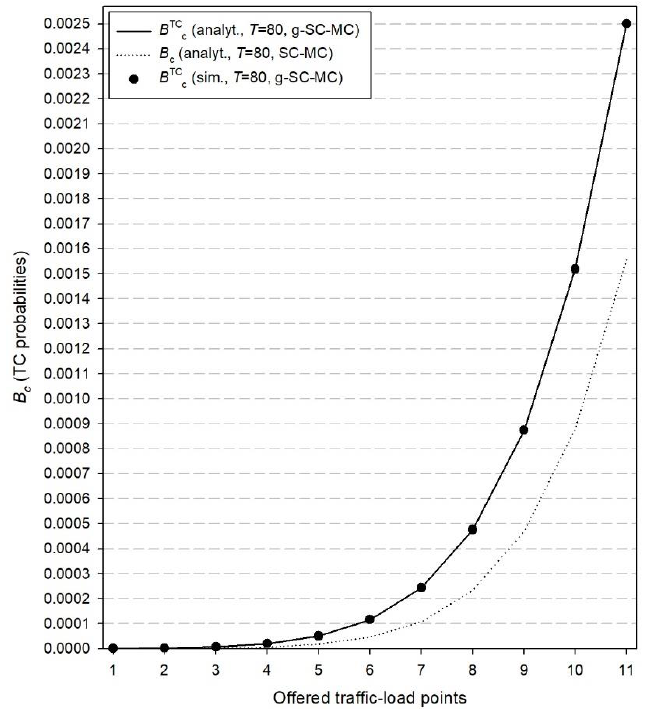
Figure 6. TC probabilities ( B TC c and B c ) for the second cluster and both